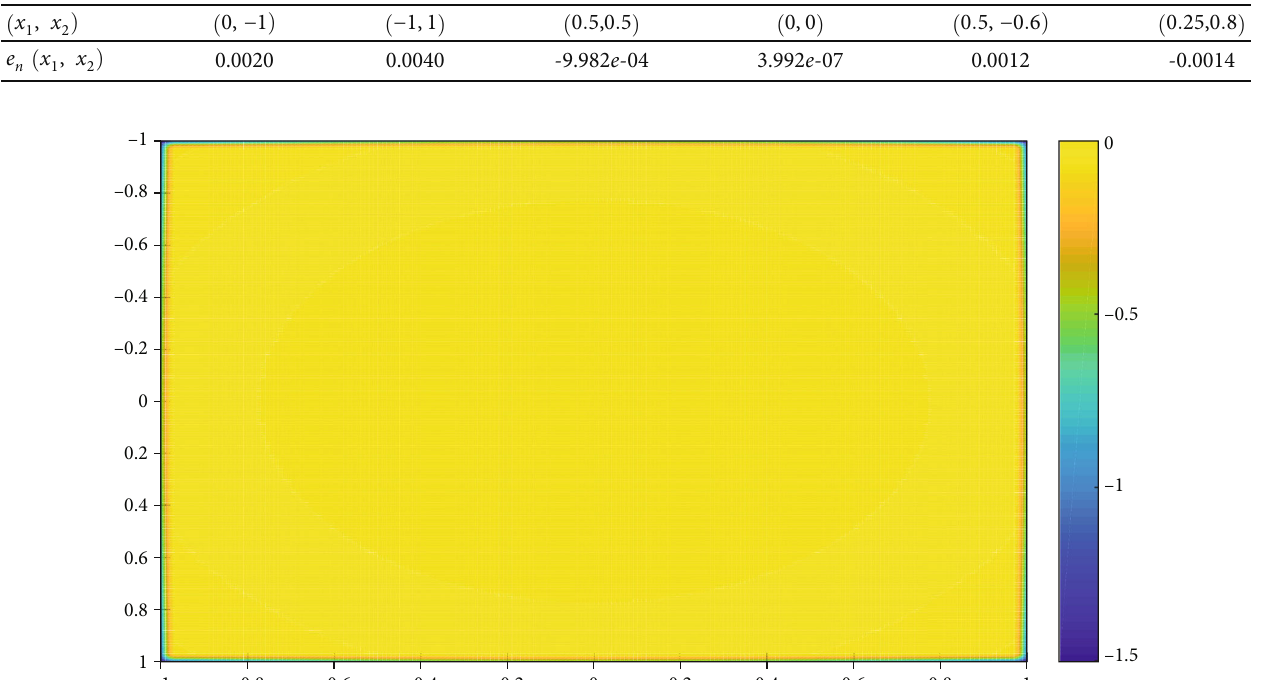
x , x fi c points with n = 1000000 . n ð 1 2 Þ for 6 speci